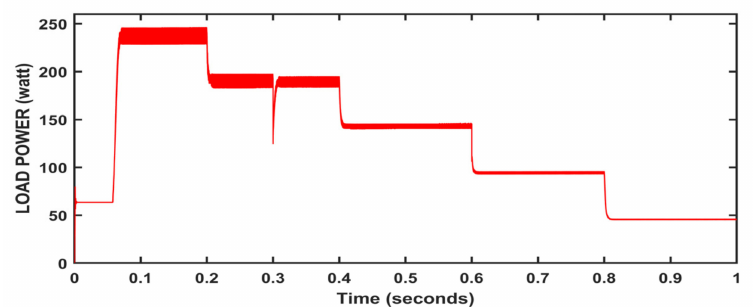
Figure 29. Output power of NN system at variable loads and variable irradiances.